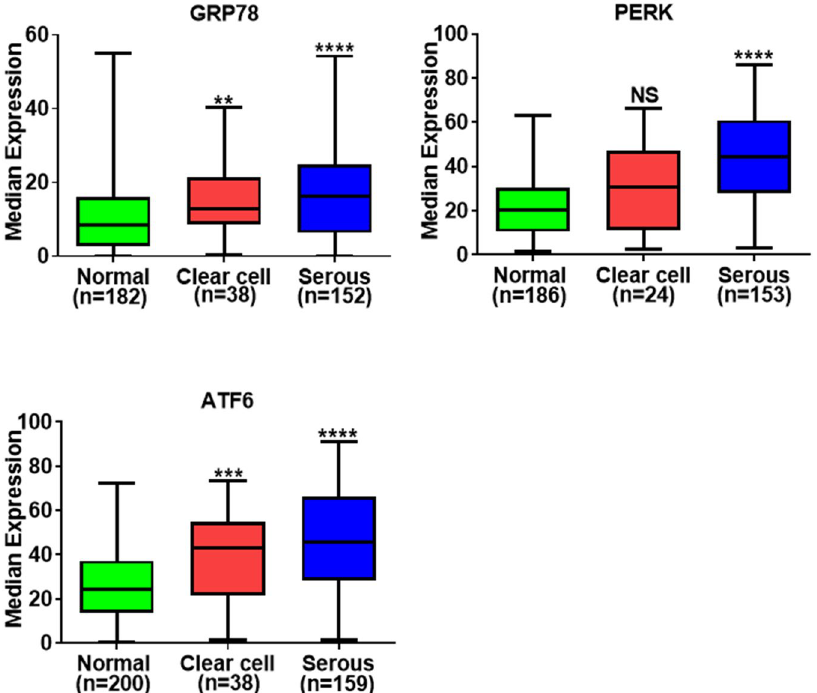
Figure 4. ER-associated proteins are overexpressed in serous and clear cell ovarian carcinoma. Protein expression levels of GRP78, PERK and ATF6 in clear cell and serous ovarian carcinoma. p -values were calculated by non parametric Mann-Whitney test in GraphPadPrism 8.1.0. **** p -value < 0.0001, *** p -value < 0.001, ** p -value < 0.01, * p -value < 0.05, NS: not